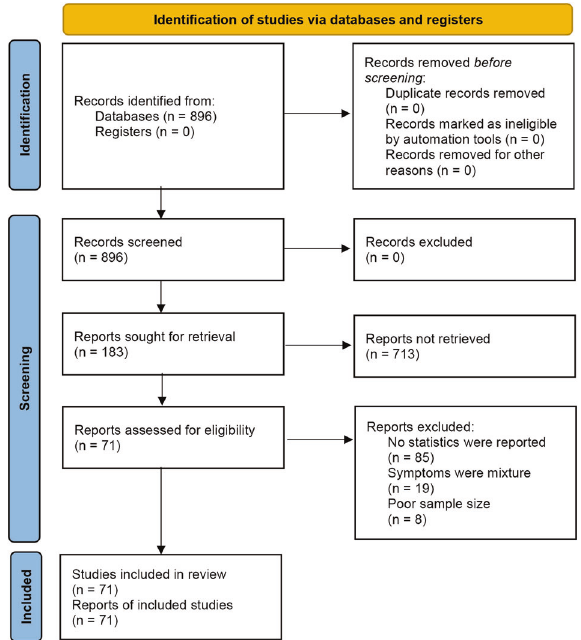
Fig. 1 Flow chart of the study selection process in the 2020 PRISMA protocol. This fl owchart is coincide with the broad-certi fi ed 2020 PRISMAstatement. Small sample size was prede fi ned as < 30